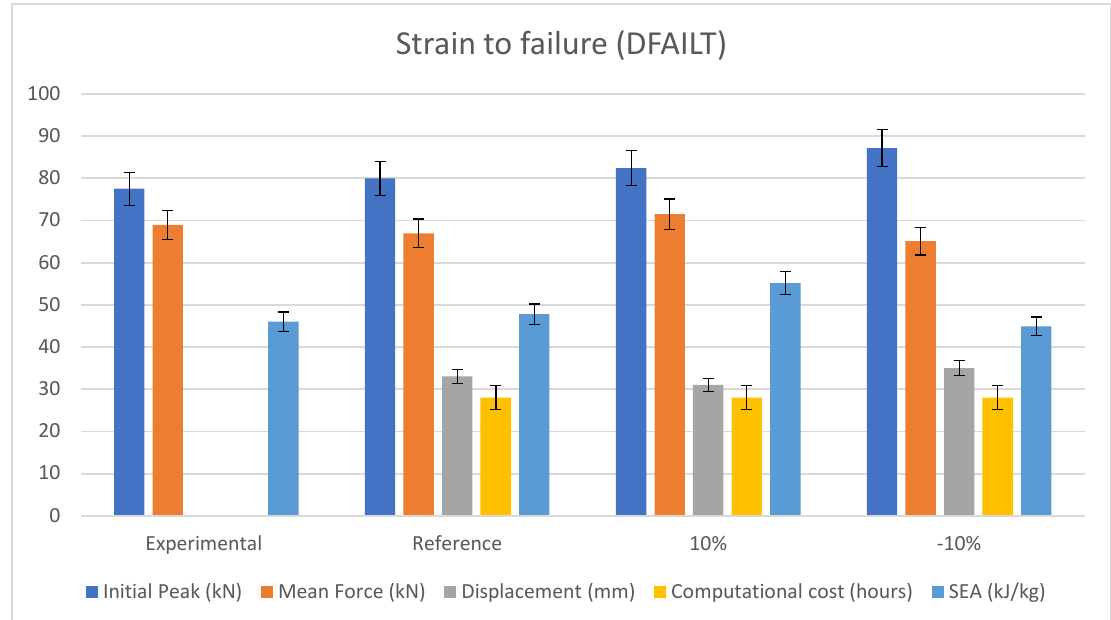
Figure 16. Strain to failure in tension (DFAILT) [66].